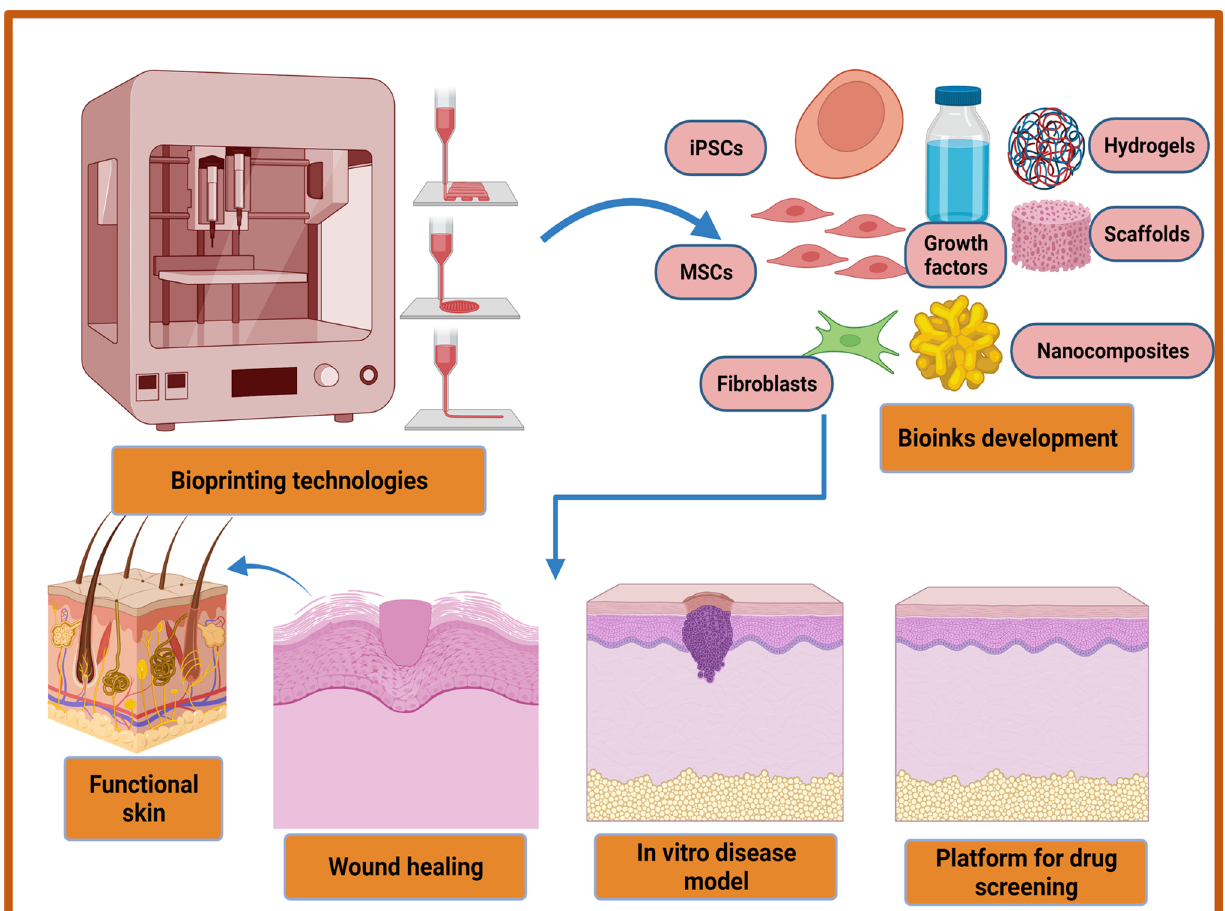
Figure 4. Recent advancements in 3D bioprinting technologies and bio-inks development for im- proved wound healing, in vitro disease model development, and the fabrication of high throughput platform for drug screening.